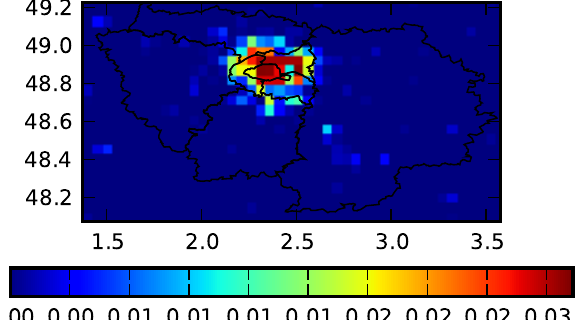
Fig. 12. Mean differences between K z values at 50m with and without the minimum urban value of K z min = 0.5m 2 s − 1 . Diffusion coefficients are averaged over six months.